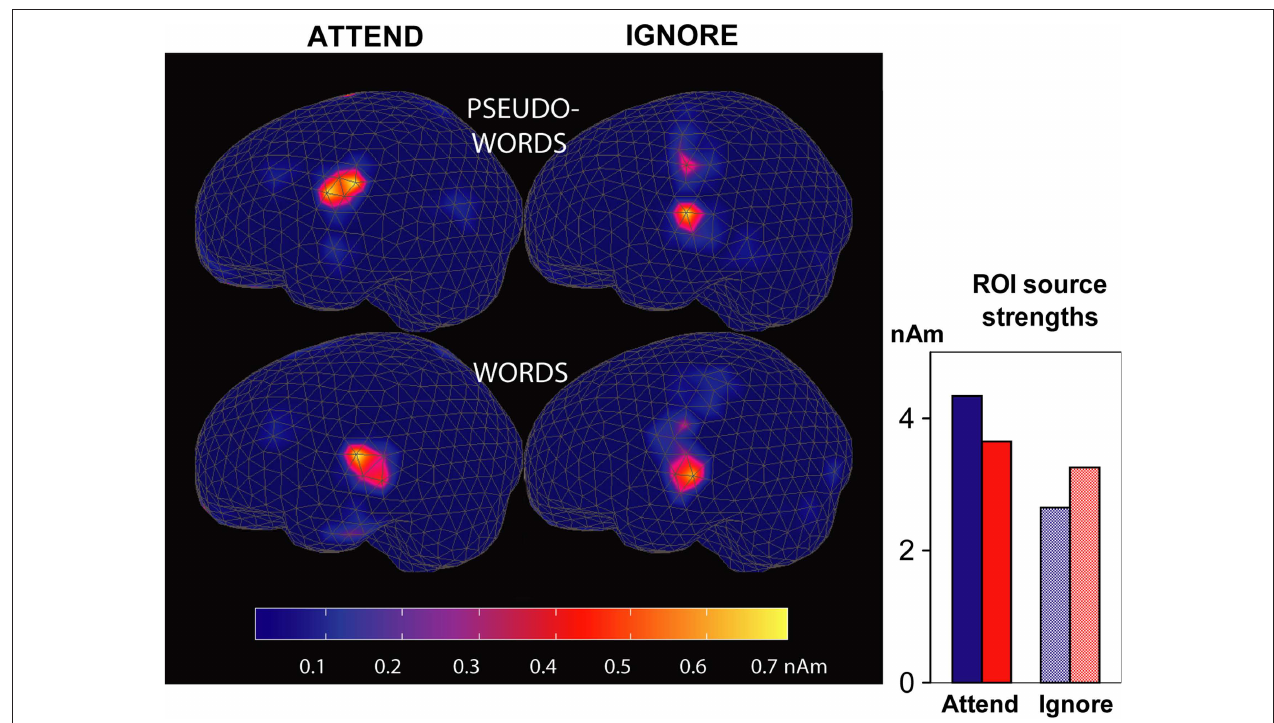
FIGURE 7 | Cortical responses to words and pseudowords in the left hemisphere. Source estimates are based on magnetic MMN responses recorded from 306 channels. Left: source distribution and average intensity